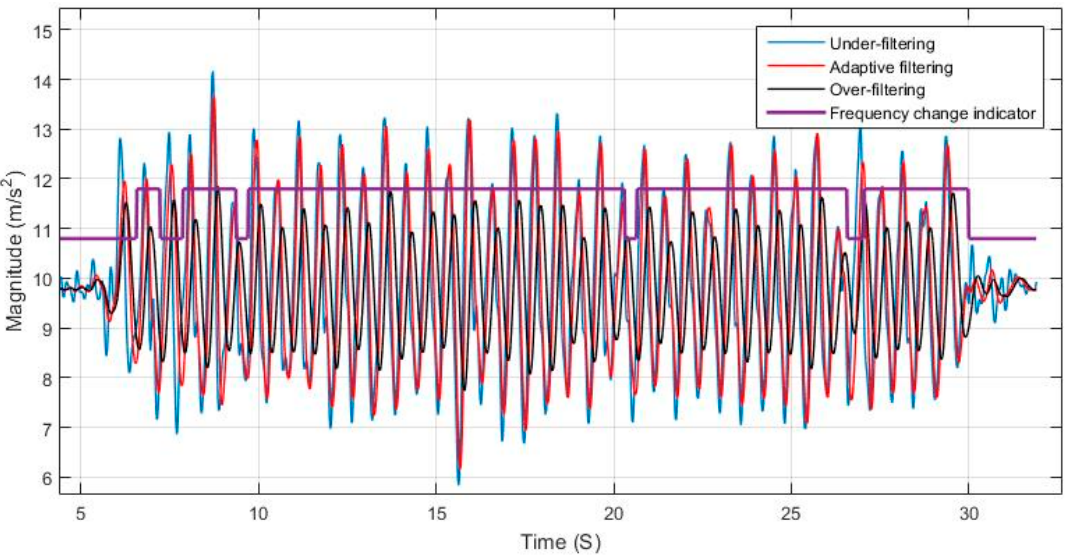
Figure 6. Adaptive filter comparison to constant cut-off frequency for nearly constant walking speed.